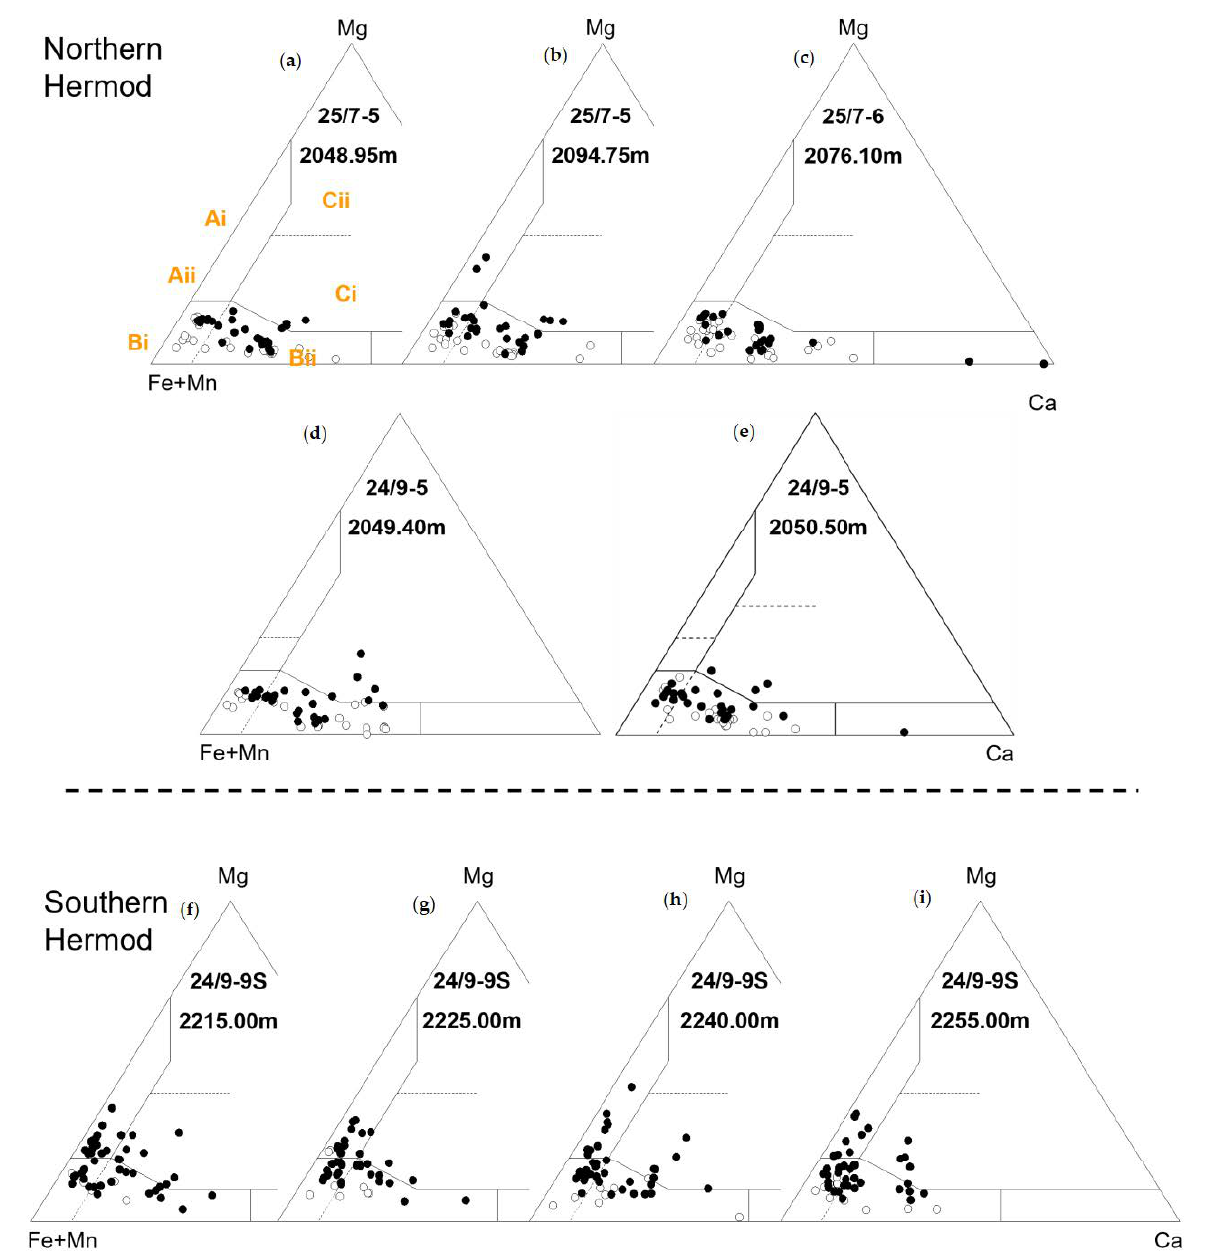
Figure 7. Ternary plots showing garnet assemblage compositions of Northern ( a – e ) and Southern ( f – i ) Hermod S2 Mbr. Northern Hermod S2 Mbr is found in Volund (24/9-5 and Kobra (25/7-5 and 25/7-6); samples from well 25/7-5 are examples of remobilized Northern Hermod S2 Mbr. Southern Hermod S2 Mbr is found in Bøyla (24/9-9S) and Caterpillar (24/9-10S). Mg — Pyrope, Fe + Mn — Almandine + Spessartine, Ca — Grossular. Filled circles-garnets with <5% Spessartine; open circles-garnets with >5% Spessartine. Garnet classification into types Ai, Aii, Bi, Bii, Ci and Cii is after Morton et al. [28], Jolley and Morton [55] and Mange and Morton [32].